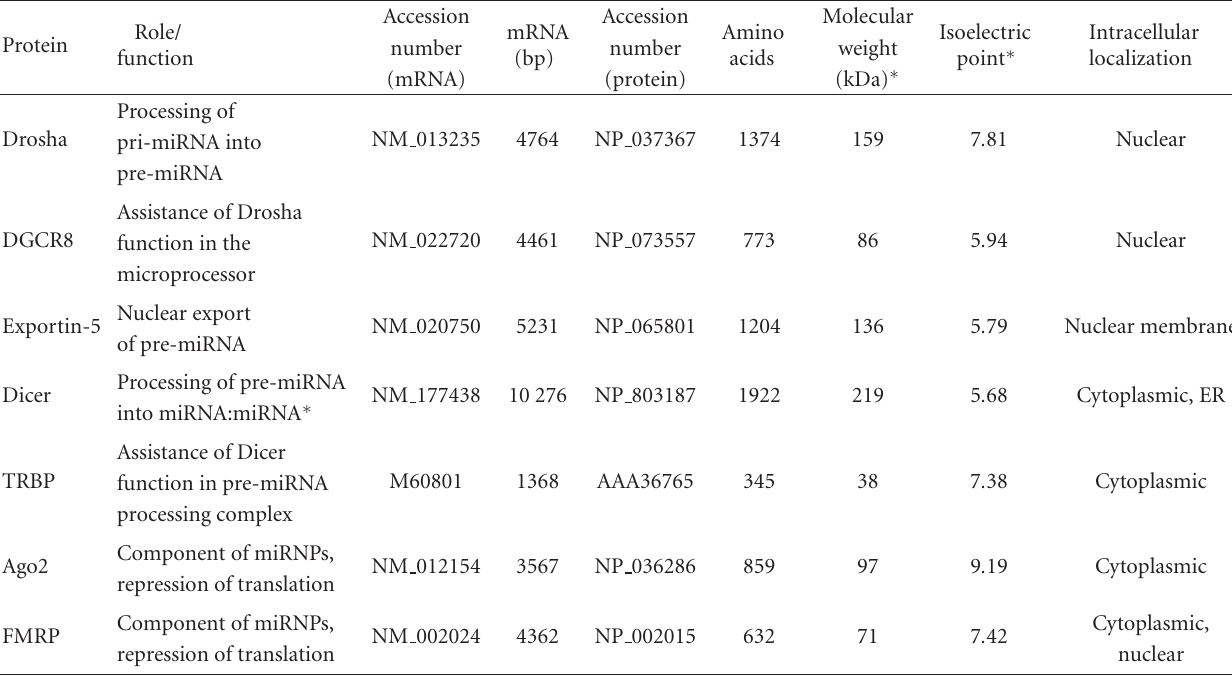
Table 1: Characteristics of the major protein components of the miRNA-guided RNA silencing